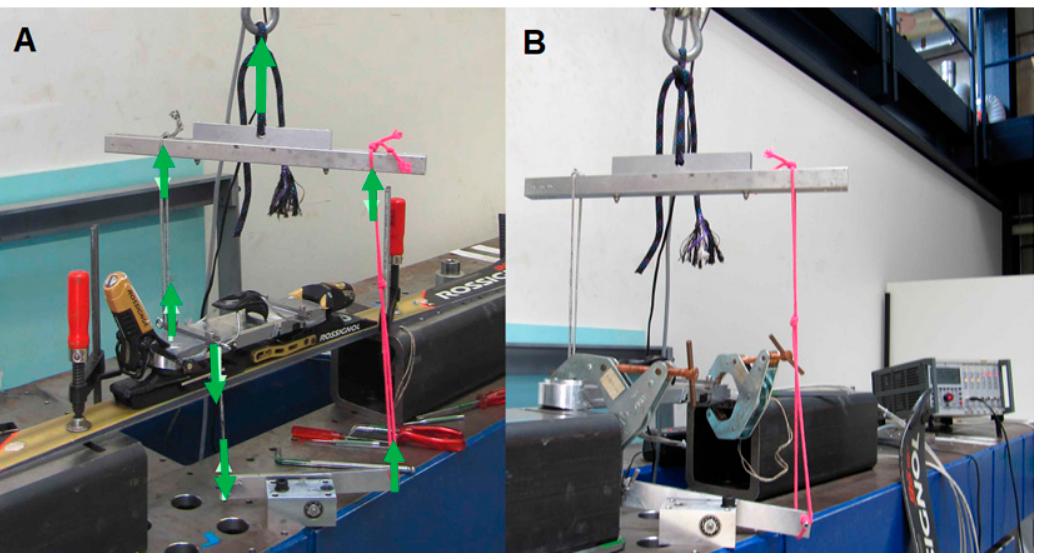
Figure 3. Setup used to calibrate torque around the X axis. The load was applied in pulling up the horizontal iron bar. On the left side of the platform, the load was directly applied in the upper direction, while on the right hand side, the load transited through a mechanical system that transferred the load in the top–down direction. ( A ) Setup with the ski. Green arrows indicate the load transmission. ( B ) Same setup but without the ski.